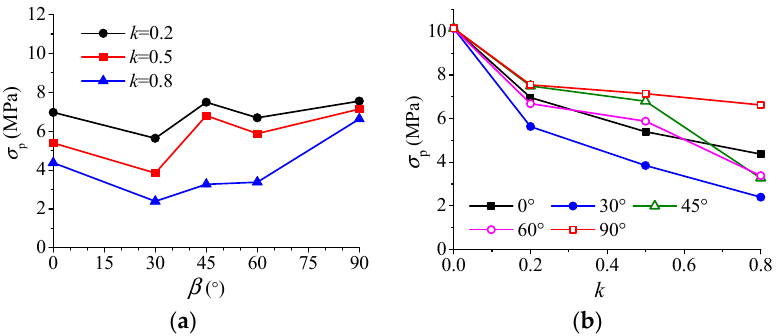
( b ) Figure 5. Young’s modulus vs. two geometrical parameters of the laboratory tests. ( a ) E vs. β ; ( b ) E vs. k . 3.2. Cracking Process The anisotropic nonlinear behavior of the jointed specimens with the hole is related to their different cracking process. Figure 6 shows the observed crack initiation types, which are classified according to their mechanism (tensile or shear, represented by T and S, respectively) and position (represented by their lower index), namely, from the matrix (T m ), joint (T j1 , T j2, and S j ), and periphery of the hole (T h and S h ). Figure 7 shows the ob- served crack coalescence types between the joints and between the hole and the joint or matrix (initial by H), respectively. Crack initiation type T m is produced by an axial tensile crack that emanates from the matrix; crack initiation type T j1 is produced by a tensile crack or a wing crack that ema- nates from the tip or middle of the joint, propagates perpendicularly first and then toward the loading direction; crack initiation type T j2 is a quasi-coplanar tensile crack that ema- nates from the joint tip, which only occurs in specimens with vertical joints; crack initia- tion type S j is a quasi-coplanar shear crack that emanates from the joint tip; crack initiation T h is a tensile crack that emanates from the roof or floor of the hole and propagates toward the loading direction; crack initiation type S h is a shear crack or crush zone having finite width that emanates from the left or right sides of the hole and propagates perpendicular to the loading direction.